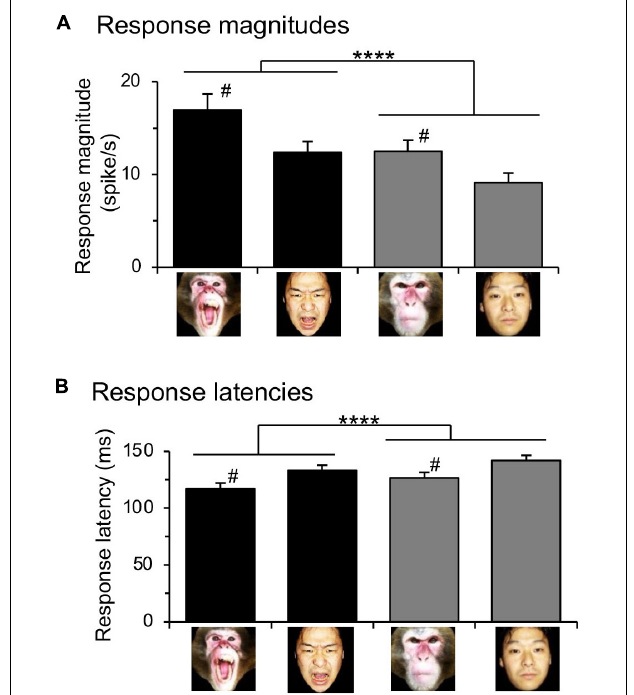
FIGURE 4 | Effects of expression and species of monkey and human faces on amygdalar neuronal responses. (A) Comparison of the mean response magnitudes. **** p < 0.0001 (significant main effect of expression: emotional vs. neutral); # p < 0.05 (significant main effect of species: monkey vs. human). (B) comparison of the mean response latencies. **** p < 0.0001 (significant main effect of expression: emotional vs. neutral); # p < 0.05 (significant main effect of species: monkey vs.